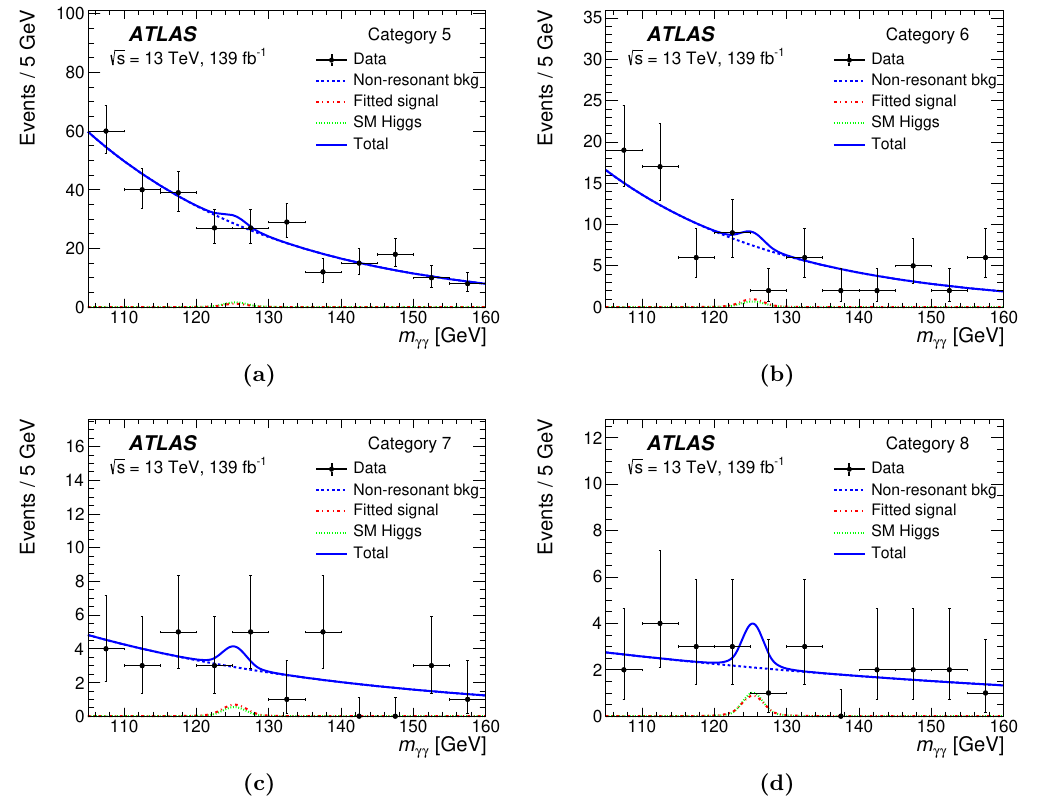
Figure 5 . Diphoton invariant mass spectra and the corresponding (cid:12)tted signal and background in the Hadronic categories (a) 5, (b) 6, (c) 7, and (d) 8. The signal samples shown correspond to ! W (cid:6) ~ (cid:31) 0 the ~ (cid:31) (cid:6) ~ (cid:31) 0 h ~ (cid:31) 0 signal with m (~ (cid:31) (cid:6) = ~ (cid:31) 0 ) = 200 GeV and m (~ (cid:31) 0 ) = 0 : 5 GeV. The non-resonant 1 2 1 1 1 2 1 background (dashed curve), the SM Higgs boson (dotted curve), and the signal (dash-dotted curve) are obtained from a simultaneous signal-plus-background (cid:12)t to the full m (cid:13)(cid:13) spectrum for the 12 categories. The total of these contributions is shown by the solid